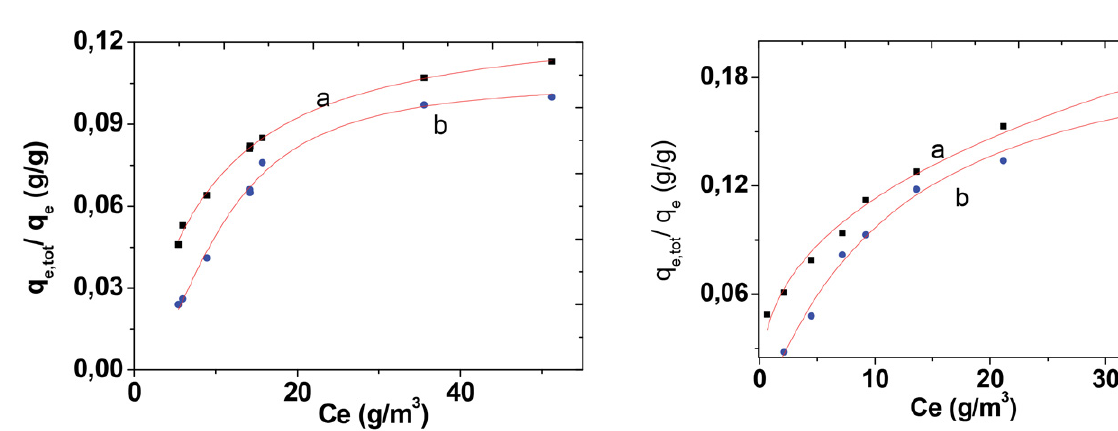
Figure 2. Adsorption Isotherms a- co-adsorption of isopropyl alco- hol -H 2 O; b- isopropyl alcohol on Adsorbent 1 (rH = 65%, t = 25 °C)